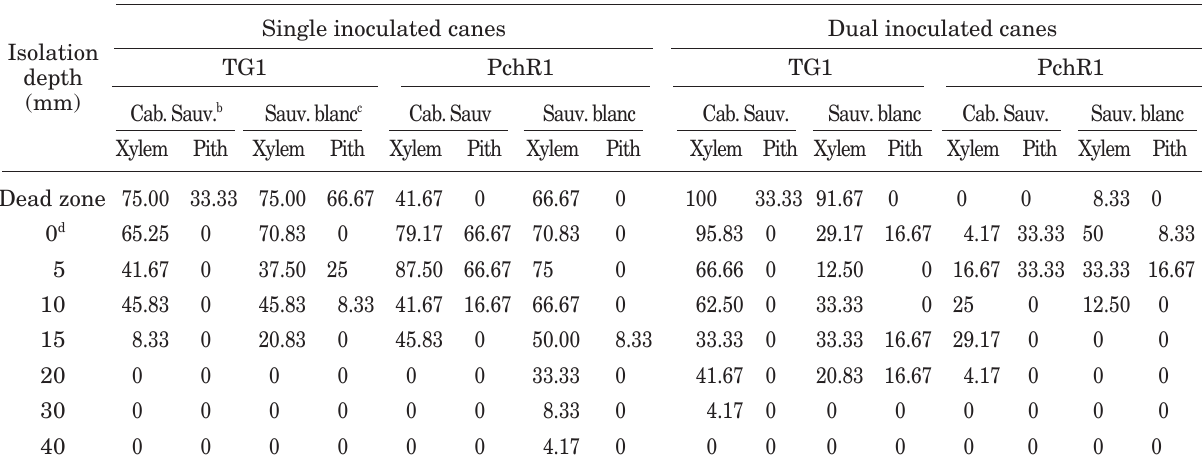
Table 1. The isolation frequency of fungi from the xylem and pith tissue at different depths 90 days after inoculation of Cabernet Sauvignon and Sauvignon blanc canes with either Trichoderma harzianum GFP (TG1) or Phaeomoniella chlamydospora DsRed (PchR1) and both fungi in dual inoculation. Grapevine pieces from where the fungi were isolated (%) a Single inoculated canes Dual inoculated canes Isolation depth (mm)